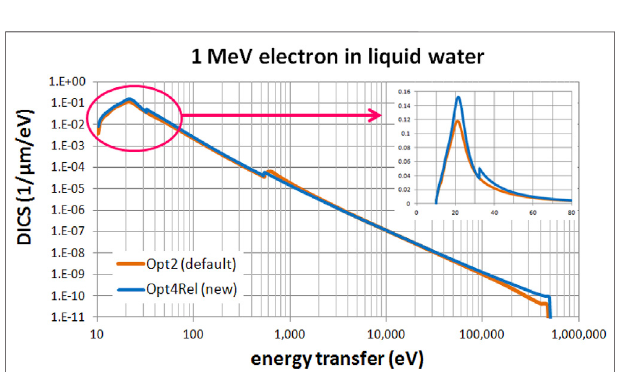
FIGURE3| Differentialionizationcrosssection(DICS)for1 MeVelectron in liquid water. Comparison between the default Opt2 and new Opt4Rel Geant4-DNA physics models. The inset focuses on the low energy-transfer part (up to 80 eV).